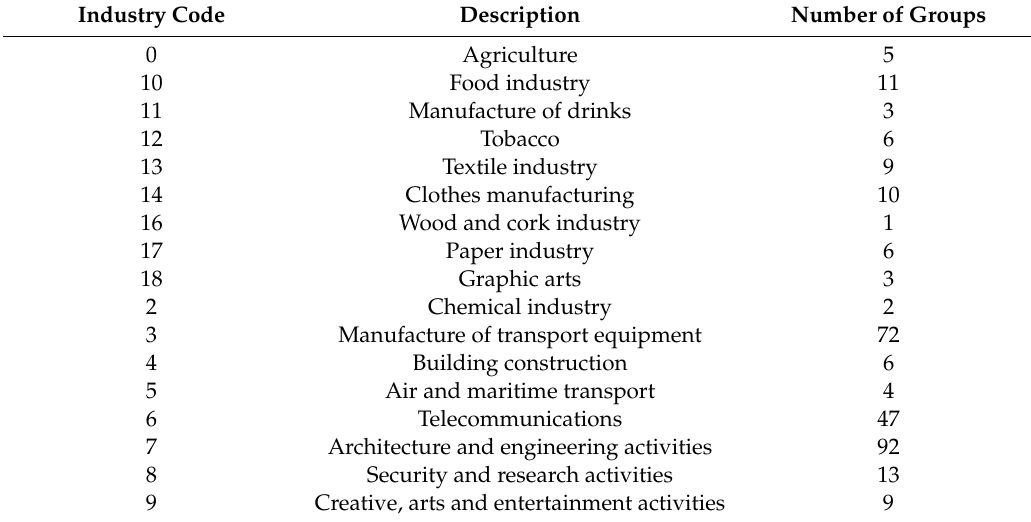
Table 1. Distribution of the sample by